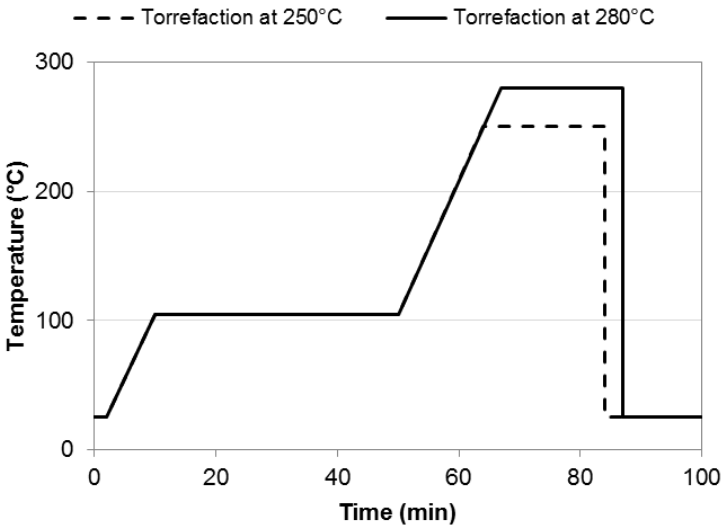
Figure 2. Temperature programs used to conduct torrefaction experiments in the